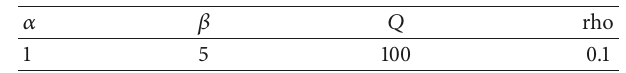
Table 5: Parameters of ACA.